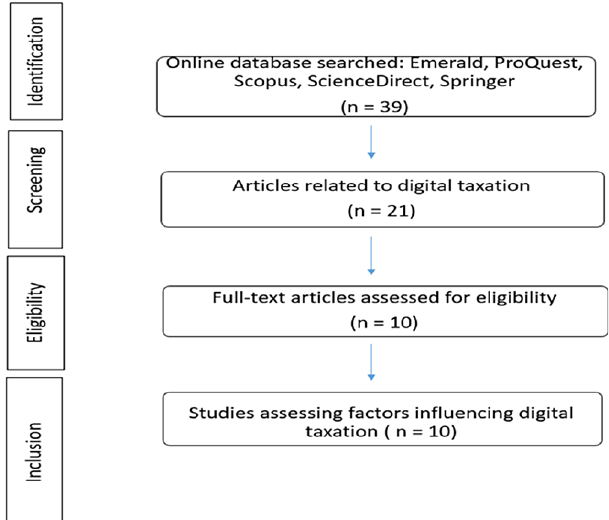
Figure 3. Prisma flow